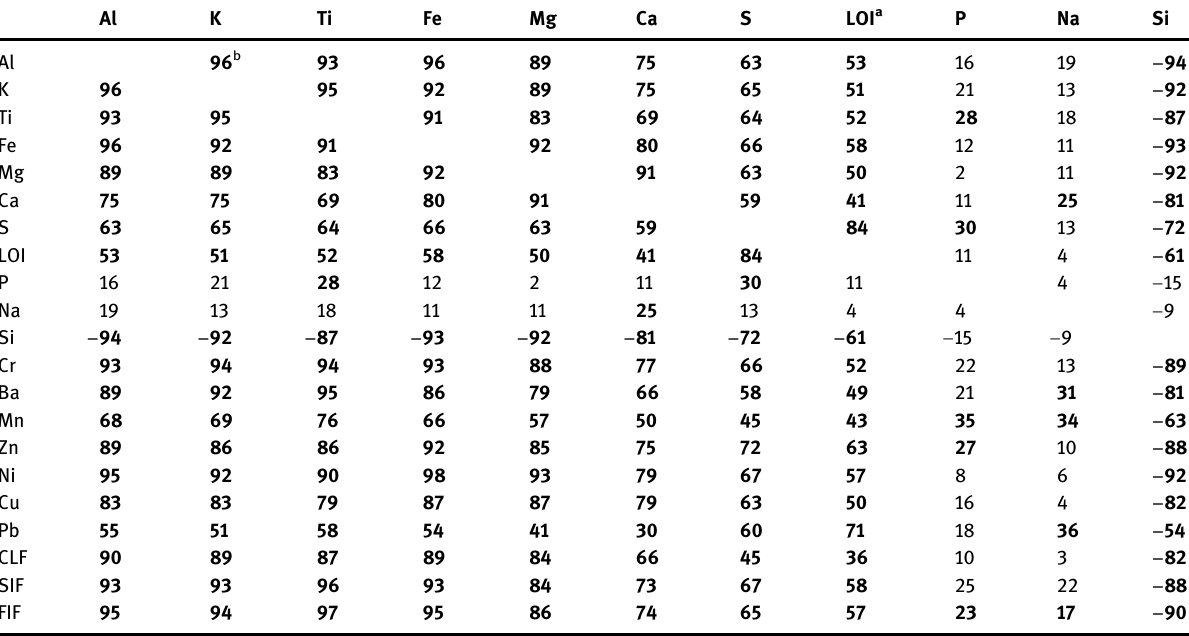
Table 4: Multiplied by 100 Spearman ’ s correlation coe ffi cients between variables